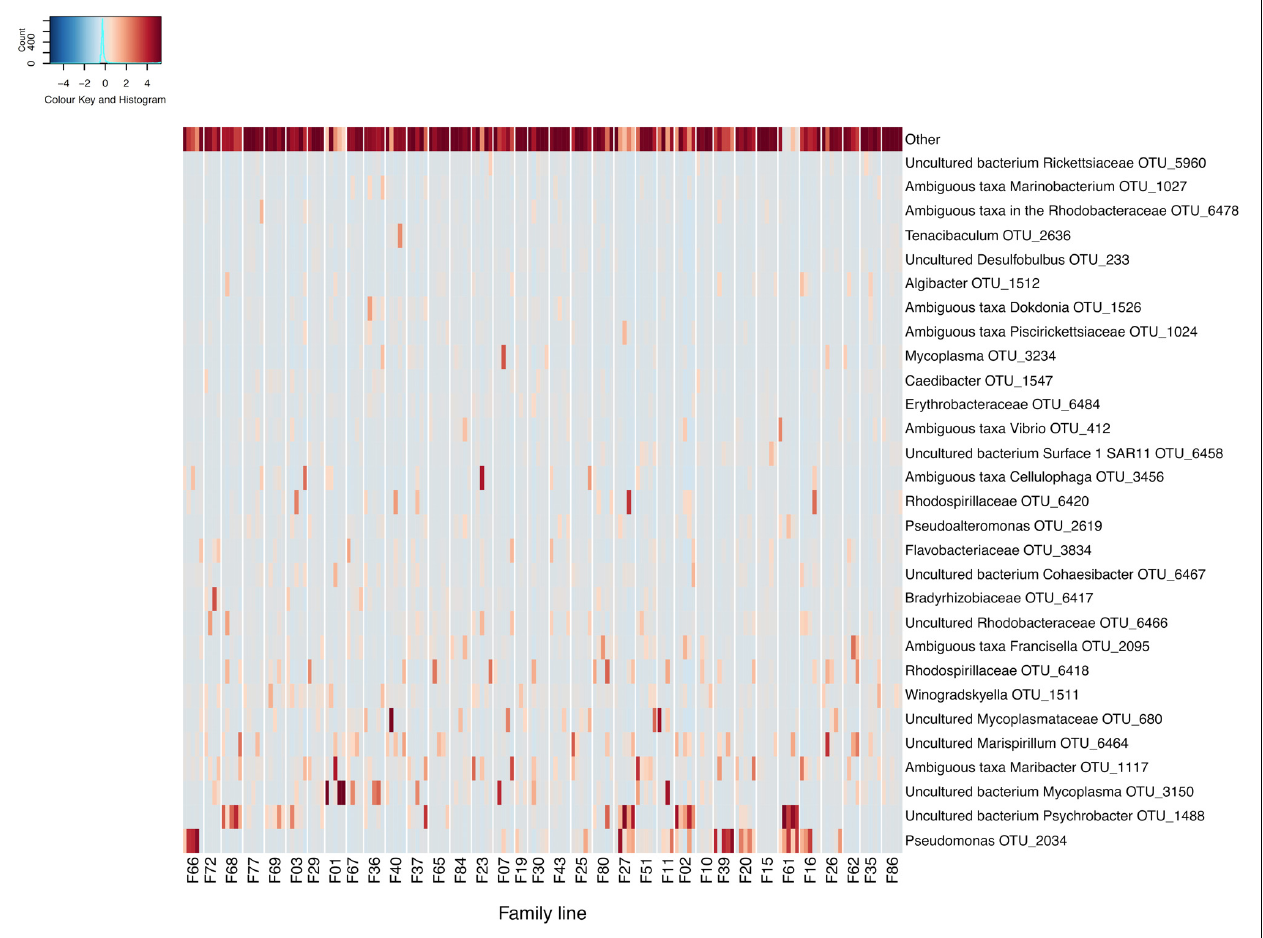
FIGURE 1 | Heatmap of scaled OTU relative abundance for the 30 most abundant OTUs, as well as the remaining summed lowly abundant OTUs. Families ordered by OsHV-1 µ var disease-resistance. Heatmap was made using the R statistical environment using scaled data with the gplots and RColorBrewer packages (Neuwirth, 2014; Warnes et al., 2016; R Core Team, 2017).